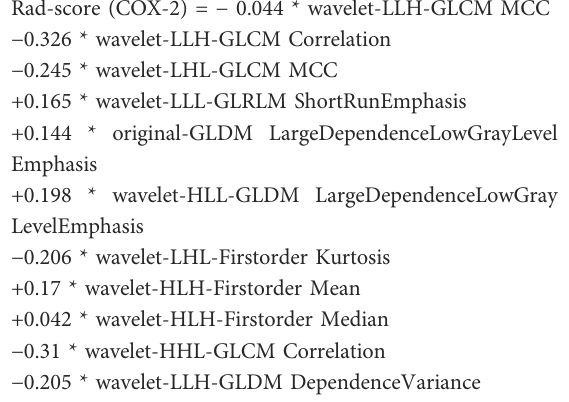
Figure 6. Partial regression coef fi cients were negative for eight of the reserved features and positive for six of the features. Rad- score (COX-2) was integrated according to the calculation formula below. The Rad-score (COX-2) was used to establish the COX-2 model with logistic regression algorithm.